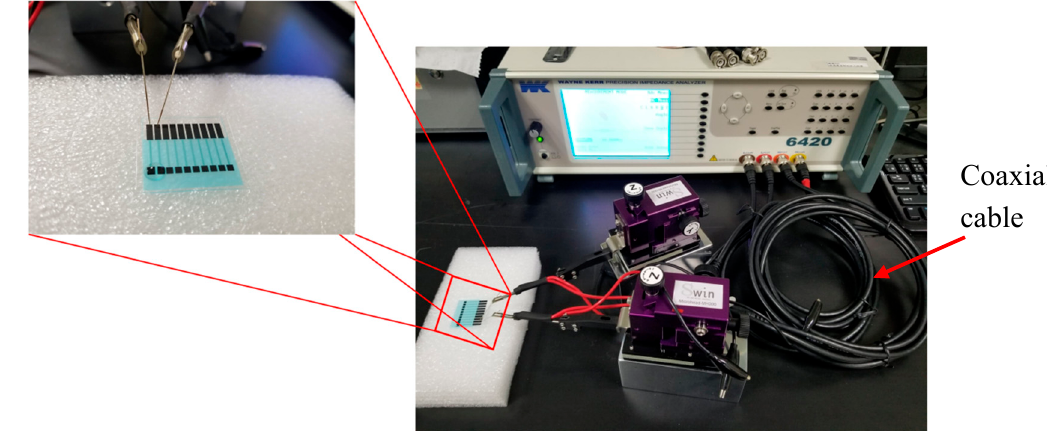
Figure 4. Impedance spectrum measurement experimental setup.